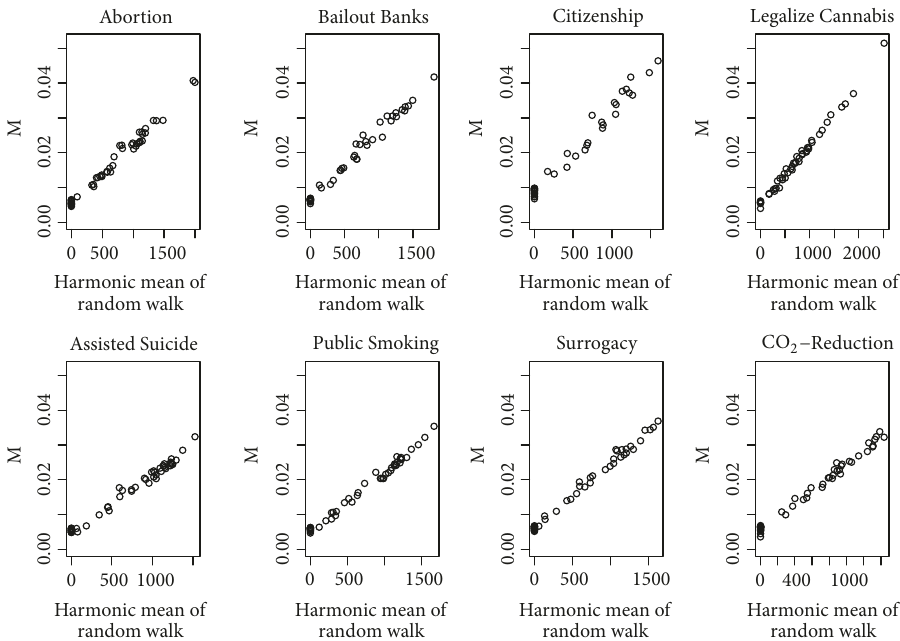
Figure 13: Mediation centrality 𝑀 of an individual (y-axes) plotted as a function of the harmonic mean of random walk residence times (across both pro and con subgraphs), separately for each policy